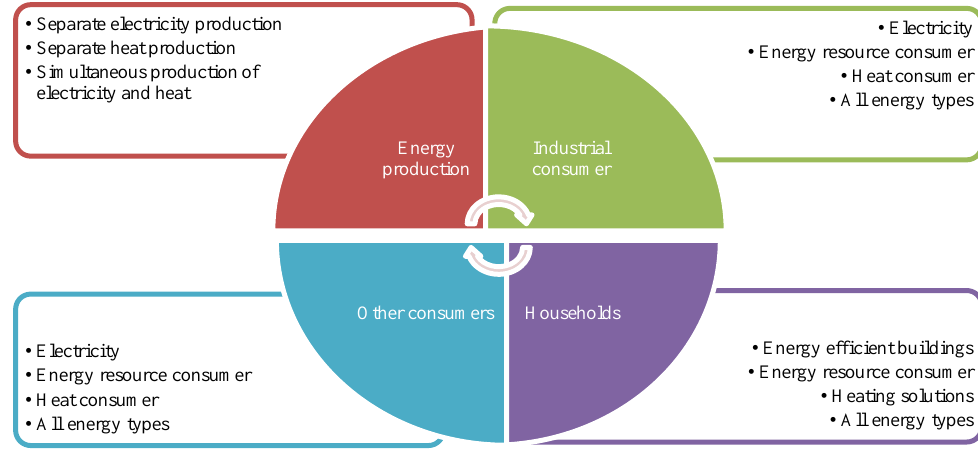
Fig. 13. Energy systems groups and current